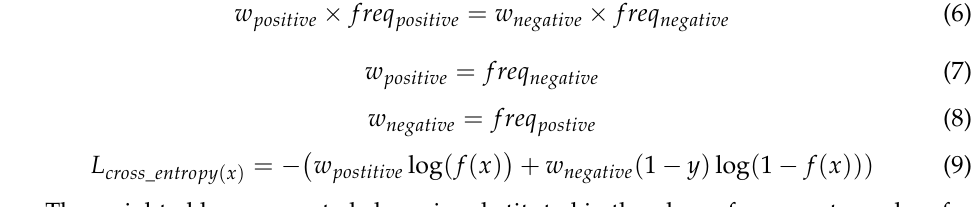
Figure 9. Deep learning with image augmentation on the unbalanced dataset.